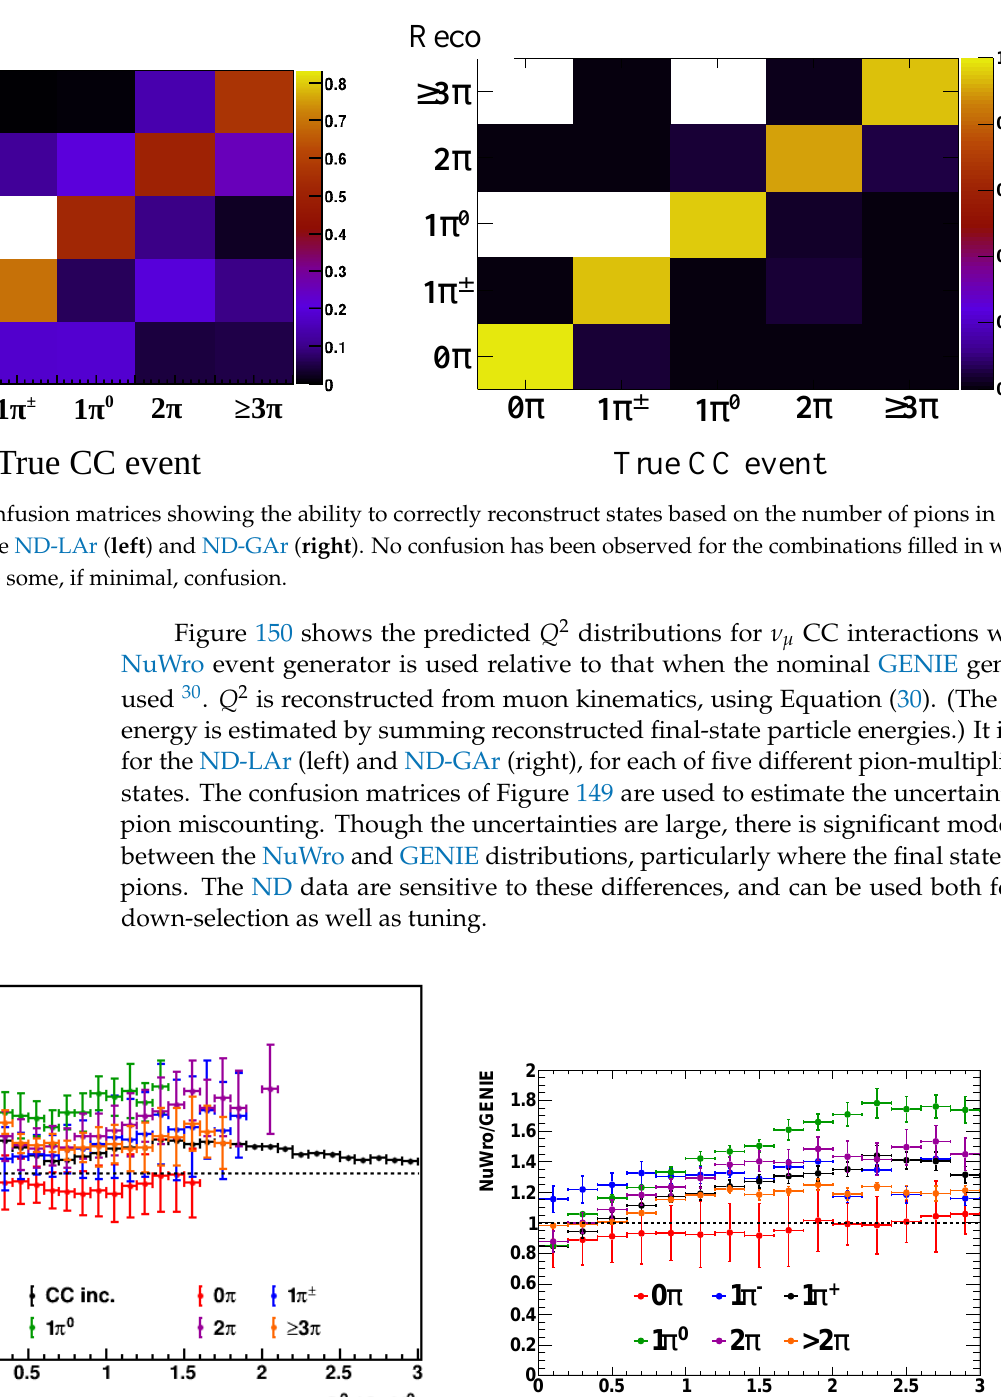
This is effectively the systematic uncertainty on these ratios as ●